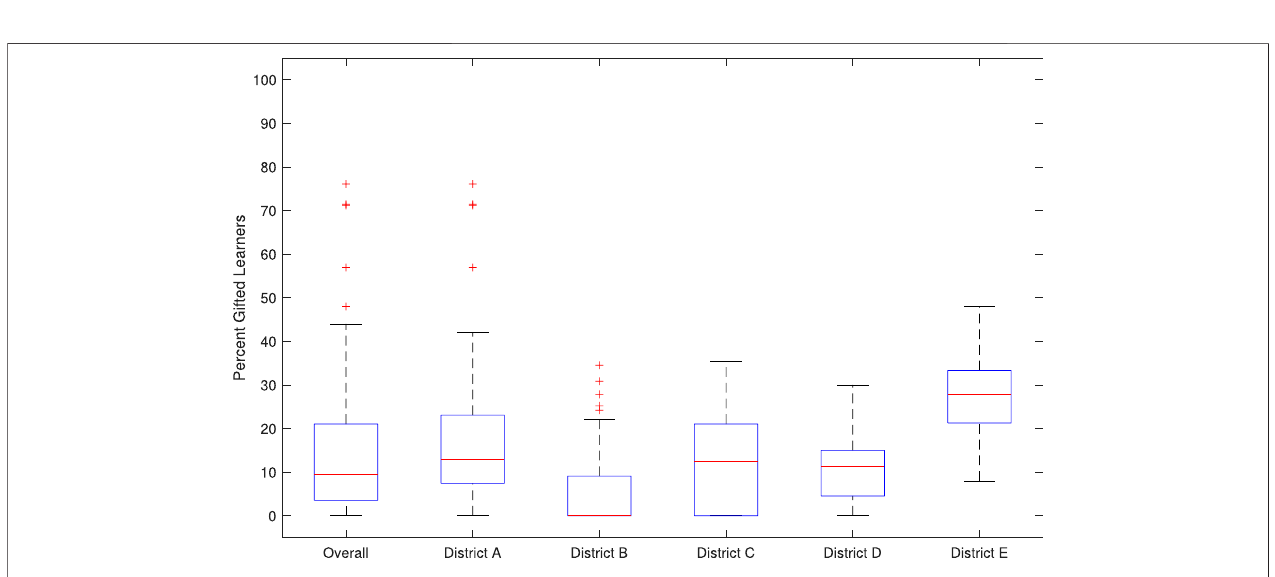
FIGURE 2 | Box plot of the percent of students in the measured classrooms ( n (cid:1) 216) designated as gifted learners, shown by district.